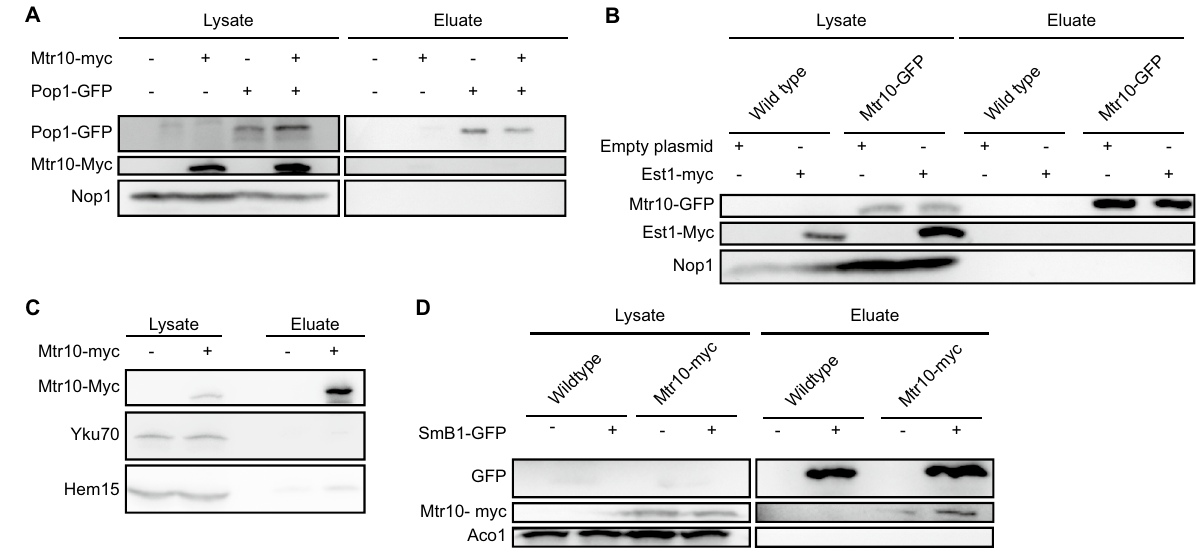
Figure 5. Both nuclear import receptors contact TLC1 at the Sm-ring. (A) Mtr10 does not interact with the Pop protein complex. A western blot of co-IPs of GFP-tagged Pop1 with myc-tagged Mtr10 is shown. Nop1 served as a washing control n = 3. Image was cropped from the original. Original image can be found in Supplementary Fig. S5.1A. ( B ) Mtr10 does not interact with the Est protein complex. A western blot of a co-IP of GFP-tagged Mtr10 with myc-tagged Est1 is shown. Nop1 served as negative control. n = 3. Image was cropped from the original. Original image can be found in Supplementary Fig. S5.2A. ( C ) Mtr10 does not interact with the Yku protein complex. A western blot of a co-IP of myc-tagged Mtr10 with Yku70 is shown. n = 3. Image was cropped from the original. Original image can be found in Supplementary Fig. S5.3A. ( D ) Mtr10 interacts with the Sm-ring. A western blot of a co-IP of GFP-tagged Smb1 with myc-tagged Mtr10 is shown. Aco1 served as a negative control. n = 3. Image was cropped from the original. Original image can be found in Supplementary Fig.